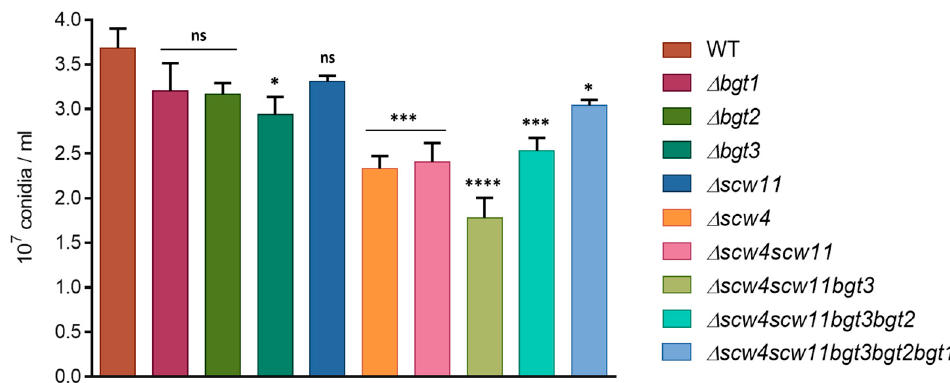
Figure 2. Conidiation of the GH17 mutant was measured after one week of growth at 37 °C. Values given were the mean of at least three replicates ± standard error.